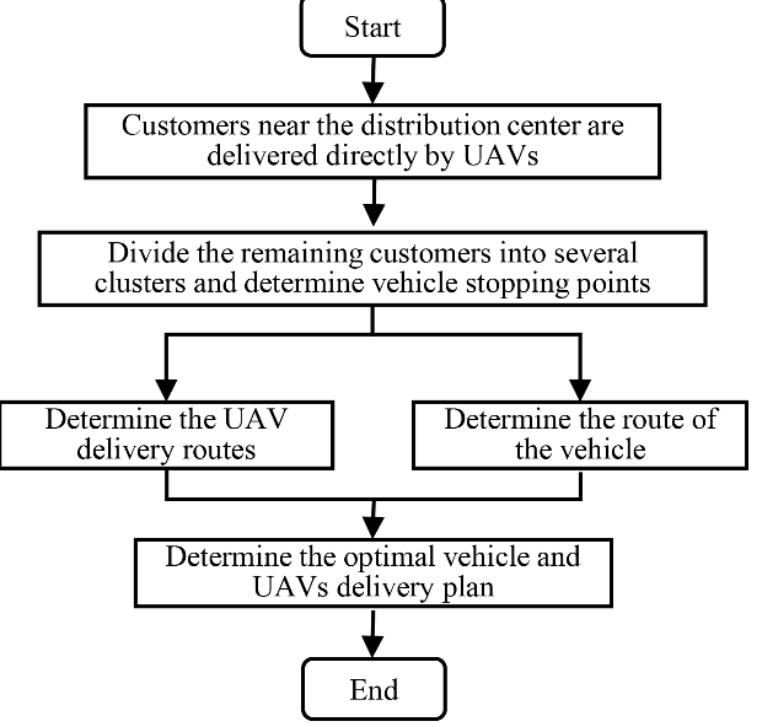
Figure 3. Process for solving vehicle-assisted UAV delivery